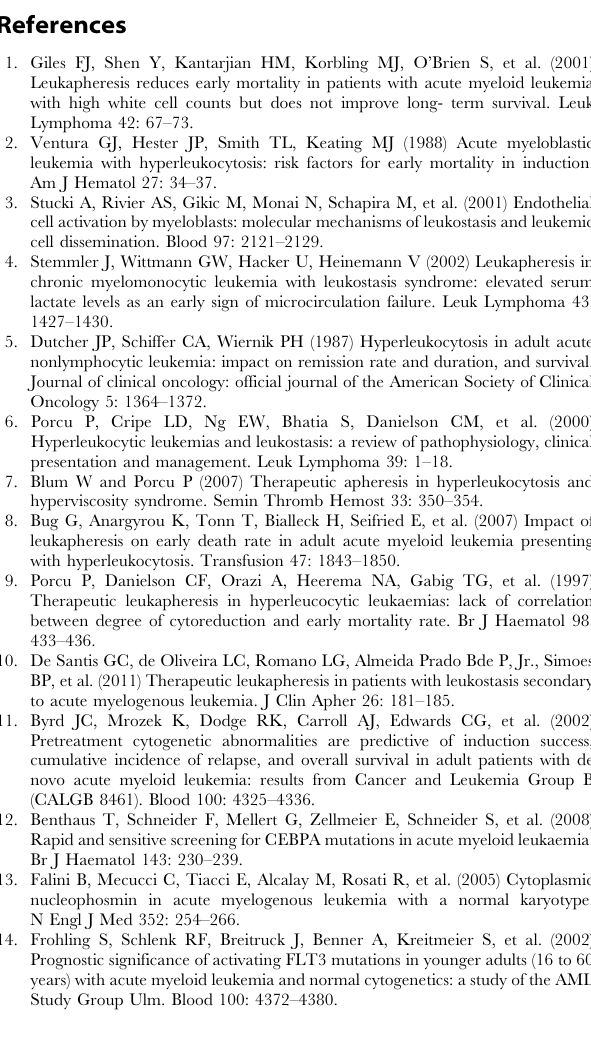
Table S2 Comparisons of patients with and without early death within 7 days (ED d7 ). Patients who died within the first seven days after diagnosis showed a worse ECOG, higher LDH levels, a more severe disturbance of coagulation (lower prothrombin time and lower fibrinogen levels) and more clinical signs of leukostasis compared to patients that survived after day 7.